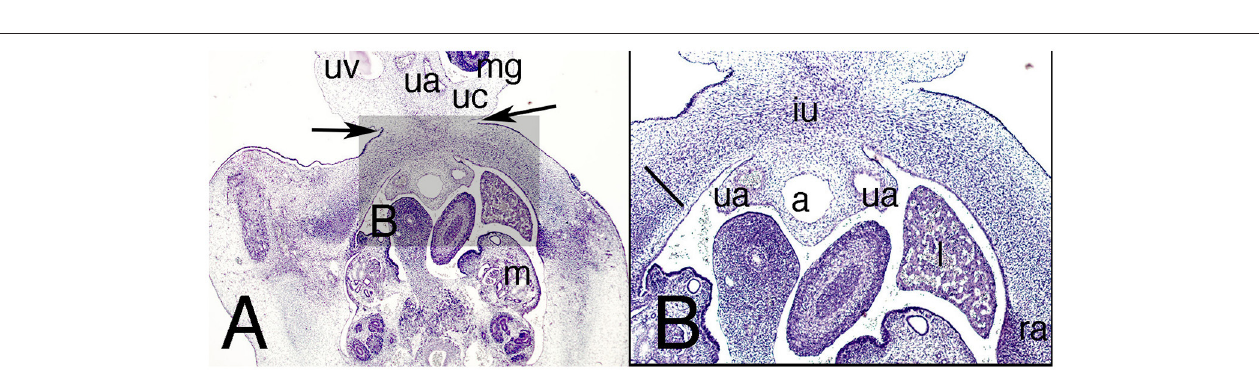
FIGURE 3 | Cross section of embryo ES-18 (stage 19) at abdominal level. Hematoxylin and eosin staining. (A) (2X) level of the physiological umbilical hernia and (B) (4X) detail of the muscles of the right abdominal wall. eo, external oblique, io, internal oblique; g, gonad; l, liver; m, mesonephros; mg, midgut; ra, rectus abdominis; t, transversus abdominis; uv, umbilical vein. Arrows, neck of the umbilical hernia.